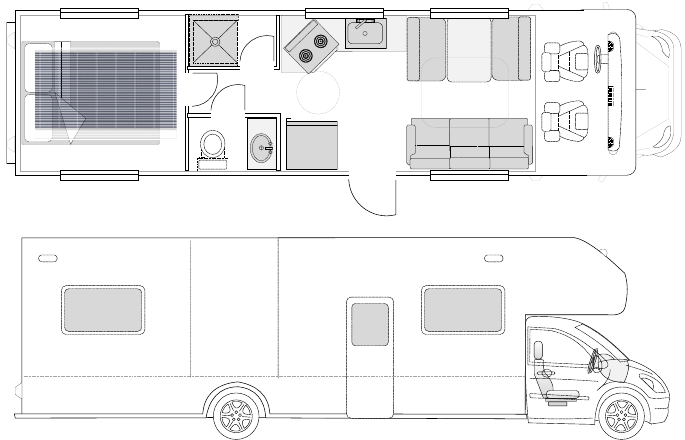
Figure 1. Placement of a flexible solar panel on the camping-car roof.